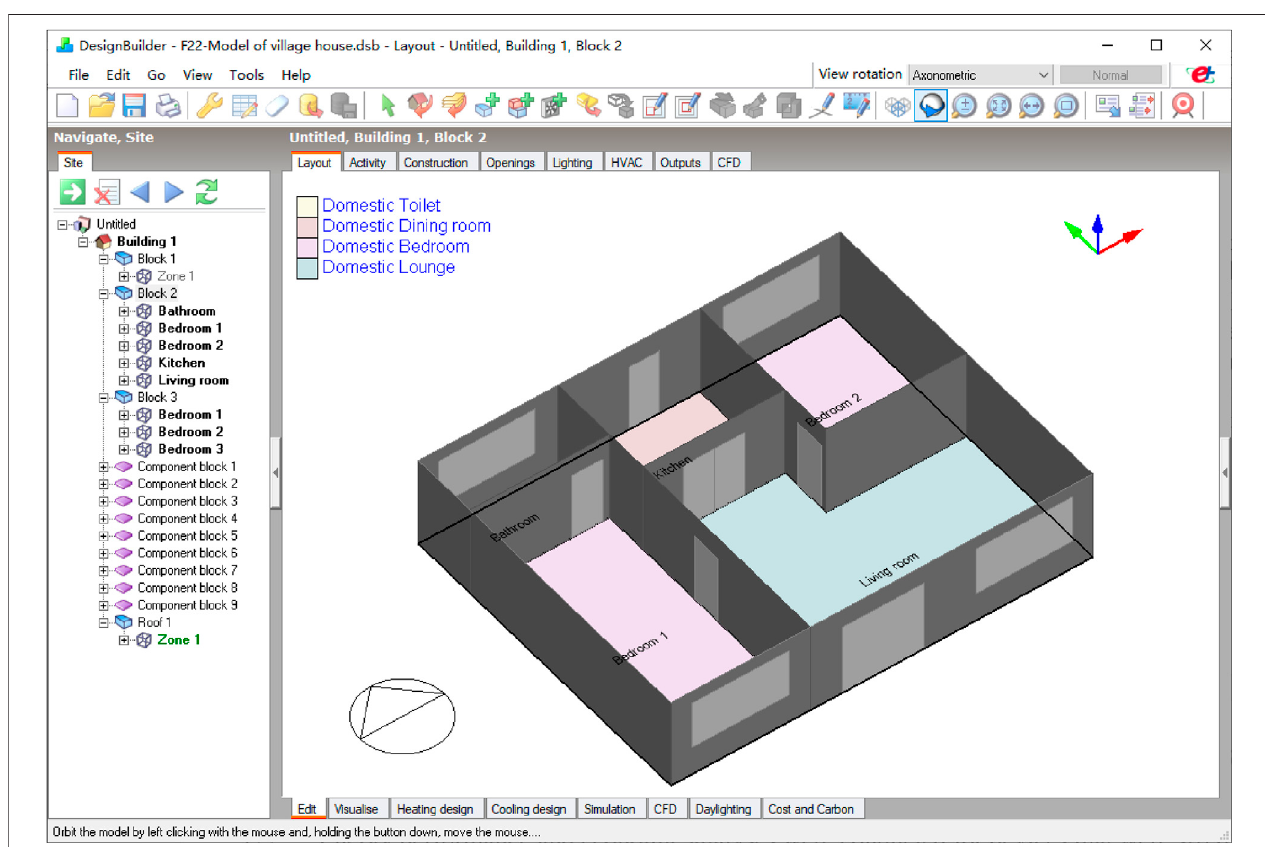
FIGURE 1 | User interface of